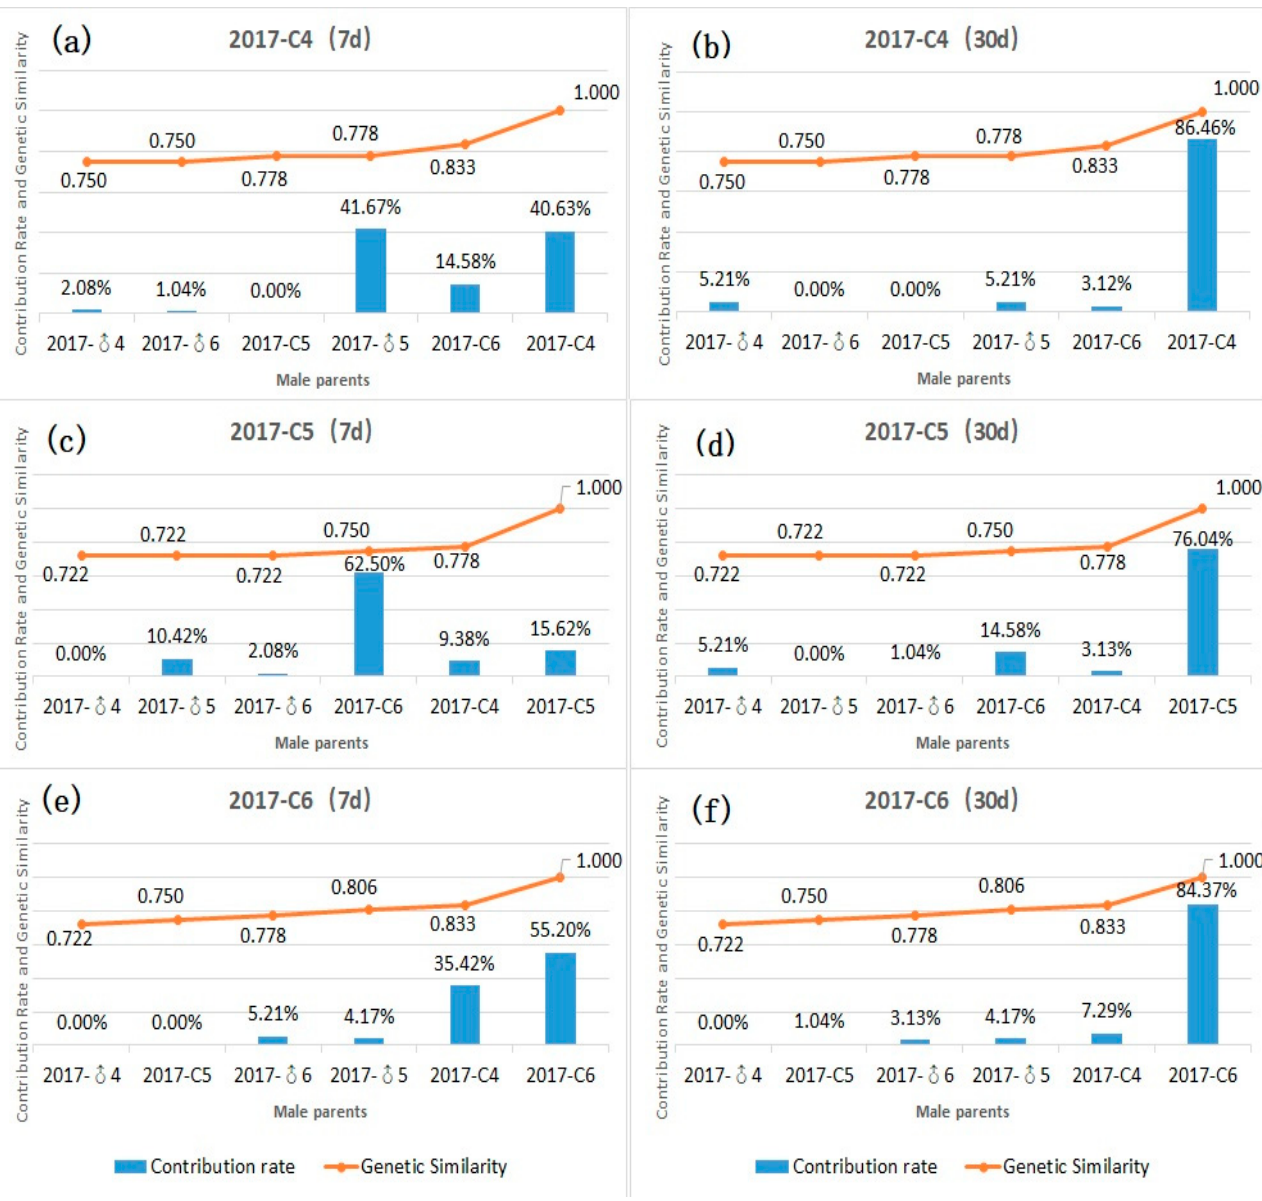
Figure 9. Contribution rate of each male parent and genetic similarity between each male parent and the female parent for the hybrid combinations: ( a ) ♀ 2017-C4, ( c ) ♀ 2017-C5, and ( e ) ♀ 2017-C6 at 7 days after pollination, and ( b ) ♀ 2017-C4, ( d ) ♀ 2017-C5, and ( f ) ♀ 2017-C6 at 30 days after pollination.